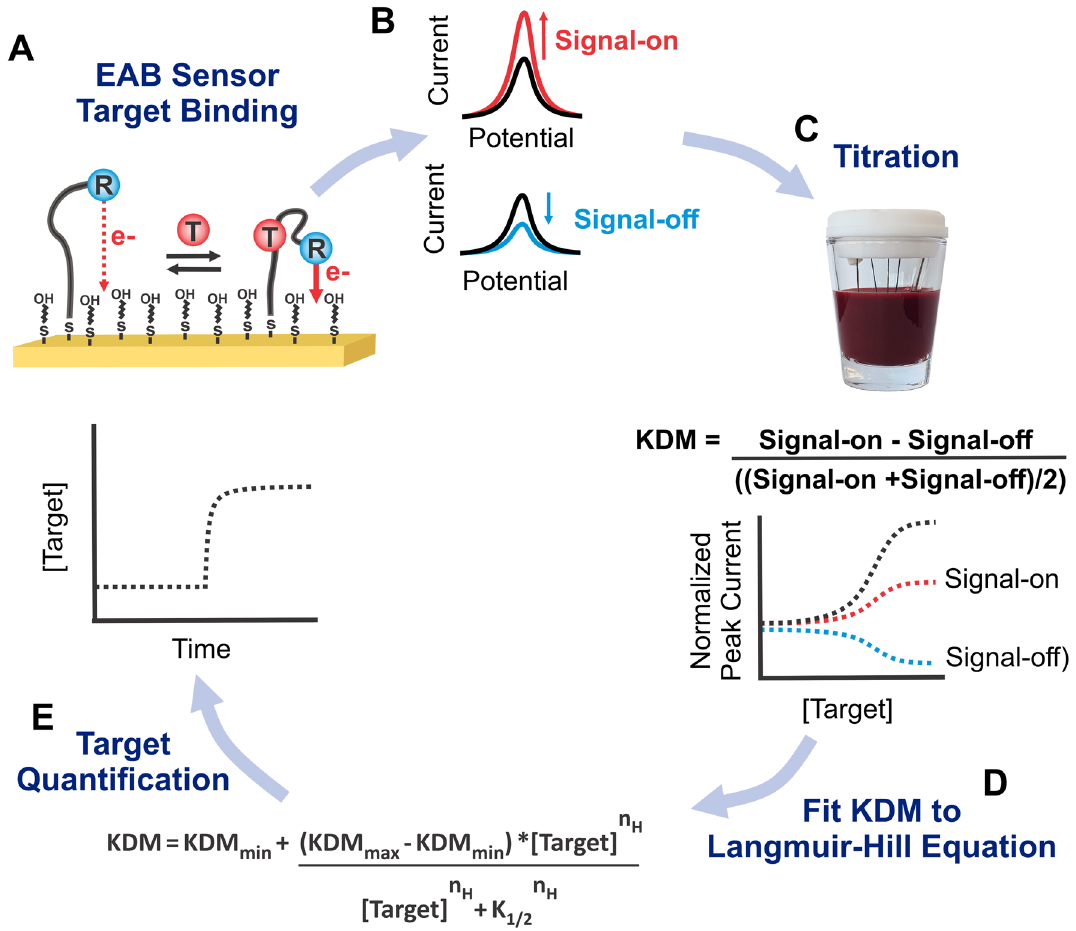
Figure 1. ( A ) EAB sensors consist of a redox-reporter-modified (R) aptamer attached to a gold electrode coated with a passivating self-assembled monolayer (here 6-mercapto-1-hexanol). Upon binding of target (T), a change in electron transfer kinetics between the redox reporter and the surface occurs, which is easily monitored using square wave voltammetry. ( B ) Depending upon the square-wave frequency employed, the peak currents seen in square wave voltammetry will increase (“signal on” behavior) or decrease (“signal off”) in response to target binding. ( C ) To determine responses at different frequencies, we titrate the sensors with known amounts of target. To increase gain and correct for the appearance of drift, we obtain Kinetic Differential Measurement (KDM) values by taking the difference in normalized peak currents collected at a signal-on and a signal-off frequency, then dividing that value by the average of the signal-on and signal-off peak currents. ( D ) We then fit the KDM values to a Hill-Langmuir equation, extracting parameters for KDM max (the maximum KDM response, or gain) KDM min and K 1/2 . ( E ) Using these parameters, we convert observed KDM measurements into concentration